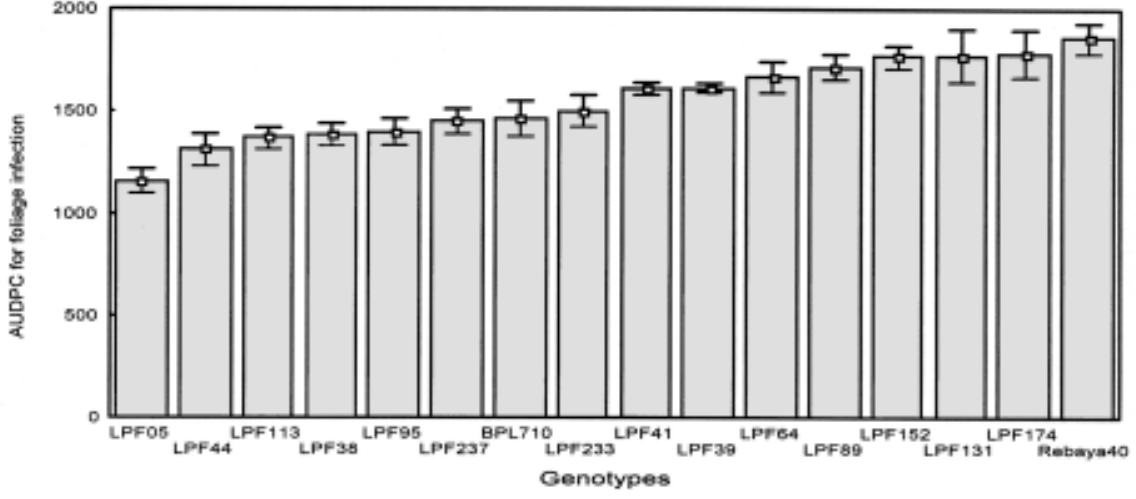
Fig. 4. Sixteen genotypes of Vicia faba classified according to area under disease progress curves (AUDPC) for foliage infection under greenhouse conditions. AUDPC values were calculated from the mass disease indexes deter- mined 0, 7, 14, 21, 30, 37 and 52 days after inoculation, and ranged from 0 to 100. Bars represent standard devia- tion.